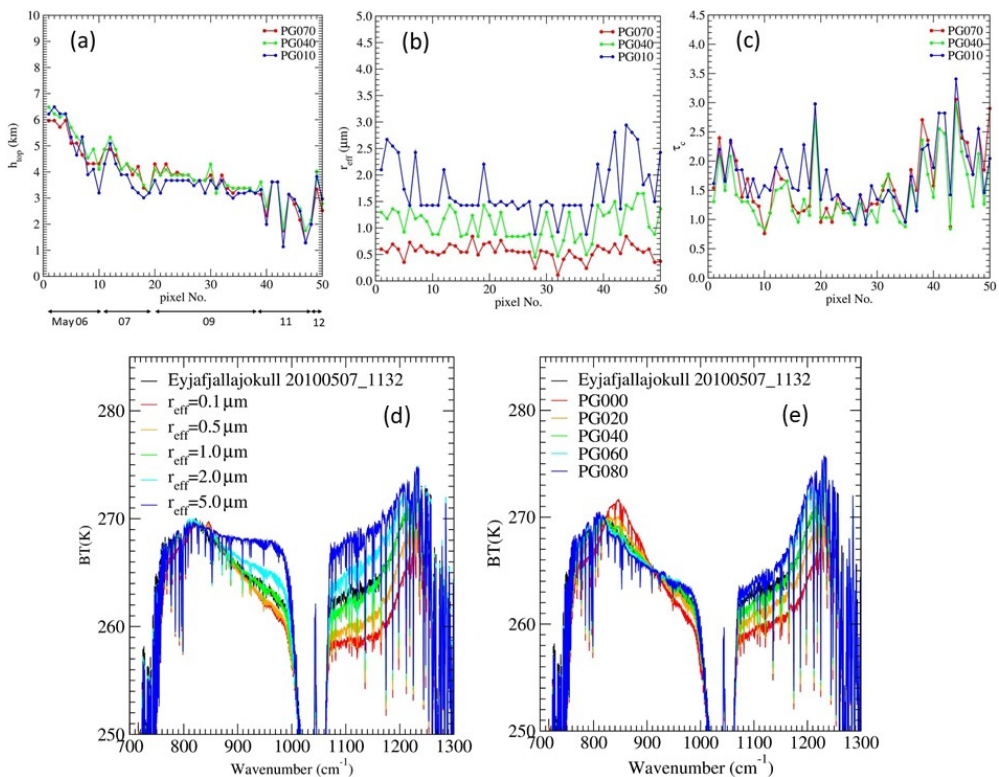
Figure 11. VAC parameters plume top height h top (a) , particle effective radius r eff (b) , and optical thickness τ c (c) estimated from our BTS analysis of 50 IASI pixels for Eyjafjallajökull VAC measurement. Observation dates corresponding to the serial number of the pixel are shown in the lower part of (a) . Panels (d) and (e) show examples of measured and calculated BTS using IASI data for pixel no. 12 (7 May 11:32UTC, (lat, long) = (61.669 ◦ N, 15.370 ◦ W)). The green line in (d, e) indicates the BTS calculated using the PG040 RI model and the VAC parameters (cid:0) h top ,r eff ,τ c (cid:1) = ( 5 . 33km , 1 . 0µm , 1 . 50 ) , while the BTS calculated after changing the r eff value is plotted in (d) . Panel (e)